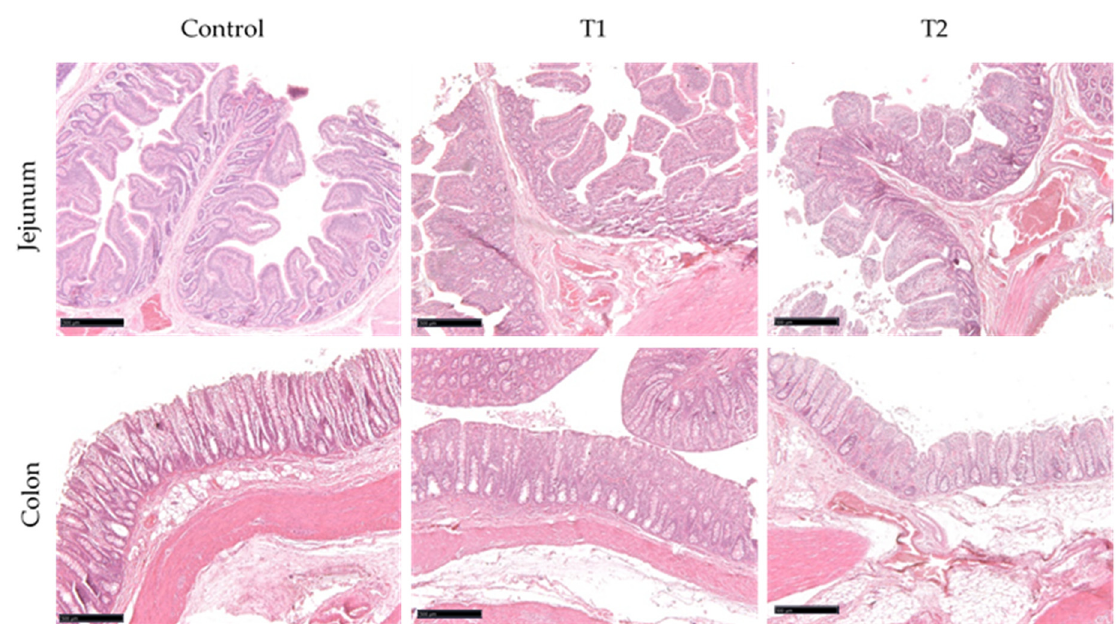
Figure 1. HE-stained sections showing the jejunum and colon morphology of control and treated groups (T1 = Control + 2.5 g GreenFIS®/kg, and T2 = Control + 5 g GreenFIS®/kg) (scale bar 500 μ m). Table 4. Evaluation of jejunum and colon histometry among control and treated groups. Item